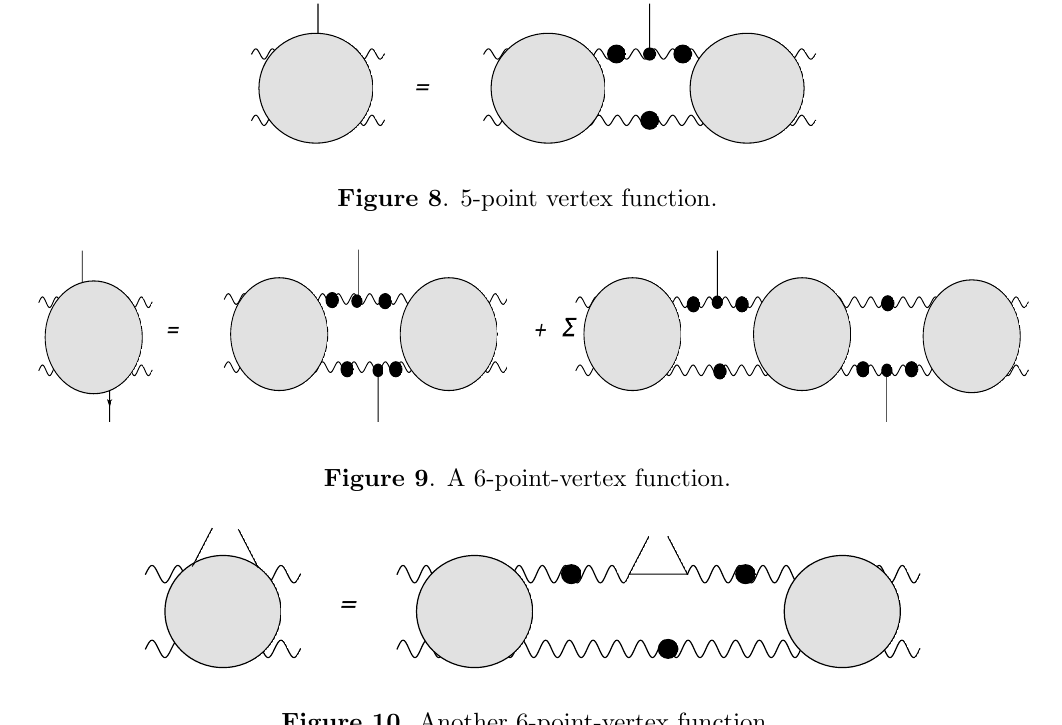
Figure 10 . Another 6-point-vertex